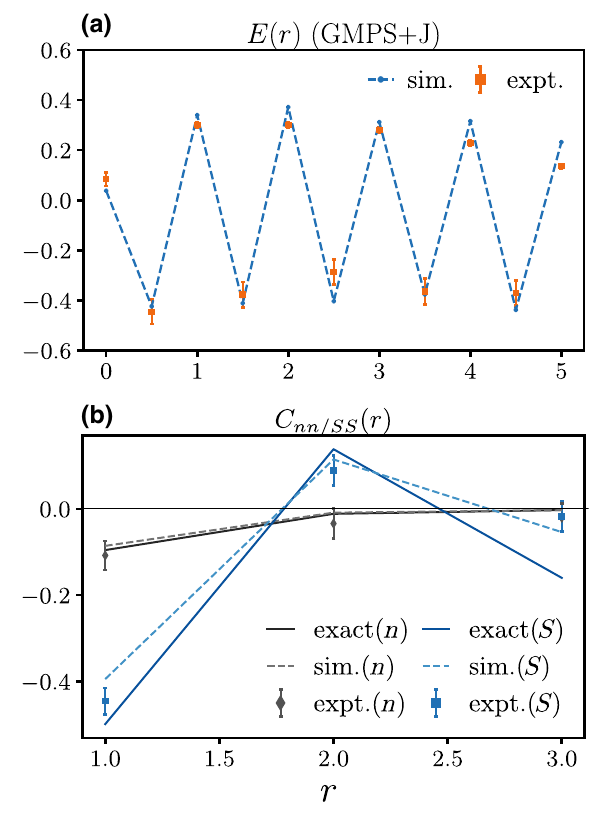
FIG. 6. GMPS+J hardware implementation—for the Fermi- Hubbard chain at half-filling with U = 4. (a) Energy density ver- sus position in the GMPS+J ansatz (which is not explicitly trans- lation invariant), with hopping energies shown at half-integer (bond-centered) positions. (b) Connected spin ( S ) and charge density ( n ) correlators show spin-charge separation with rapid decay of charge and slower (antiferromagnetically modulated) decay of spin